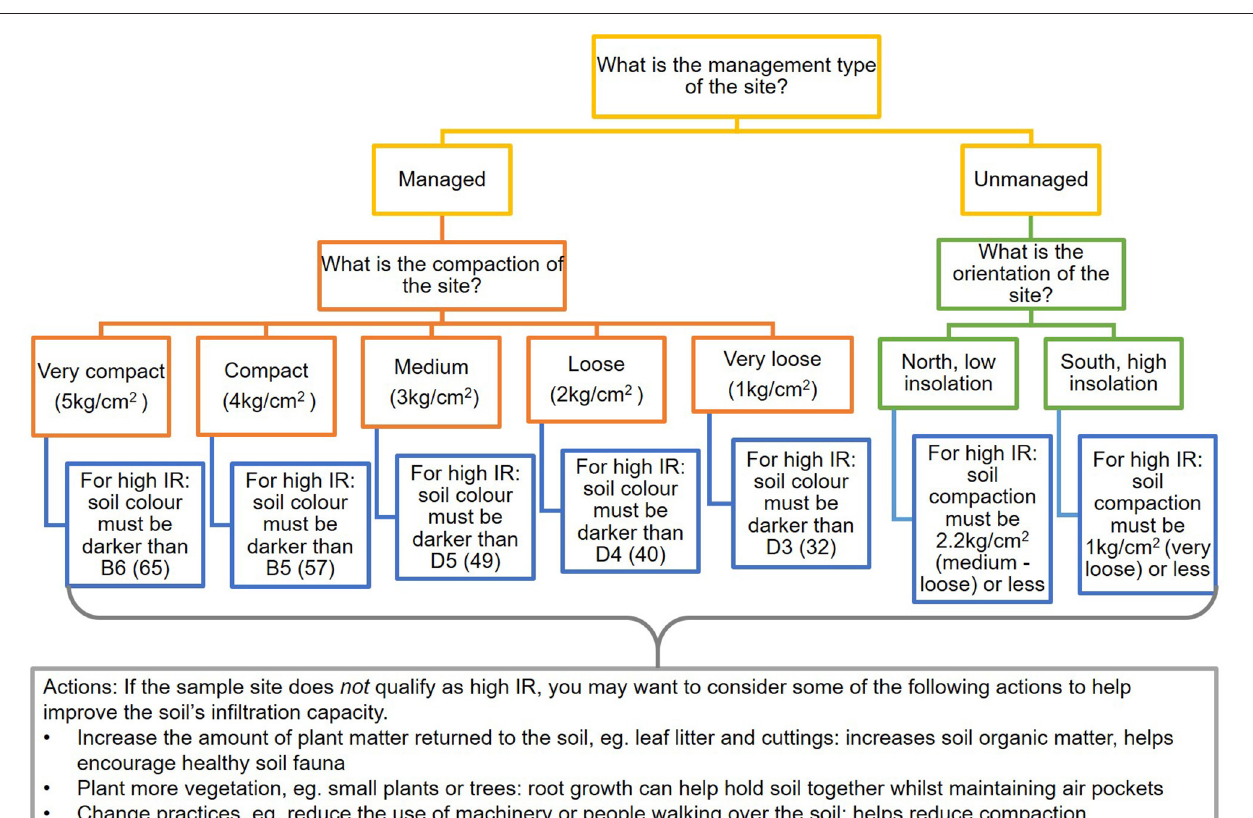
FIGURE 5 | Classification flow diagram for citizen scientists to estimate the infiltration potential of their local urban green space, and suggested actions to take to improve infiltration potential if samples cannot be classified as high infiltration rate (Soil Association, 2016). IR = Infiltration